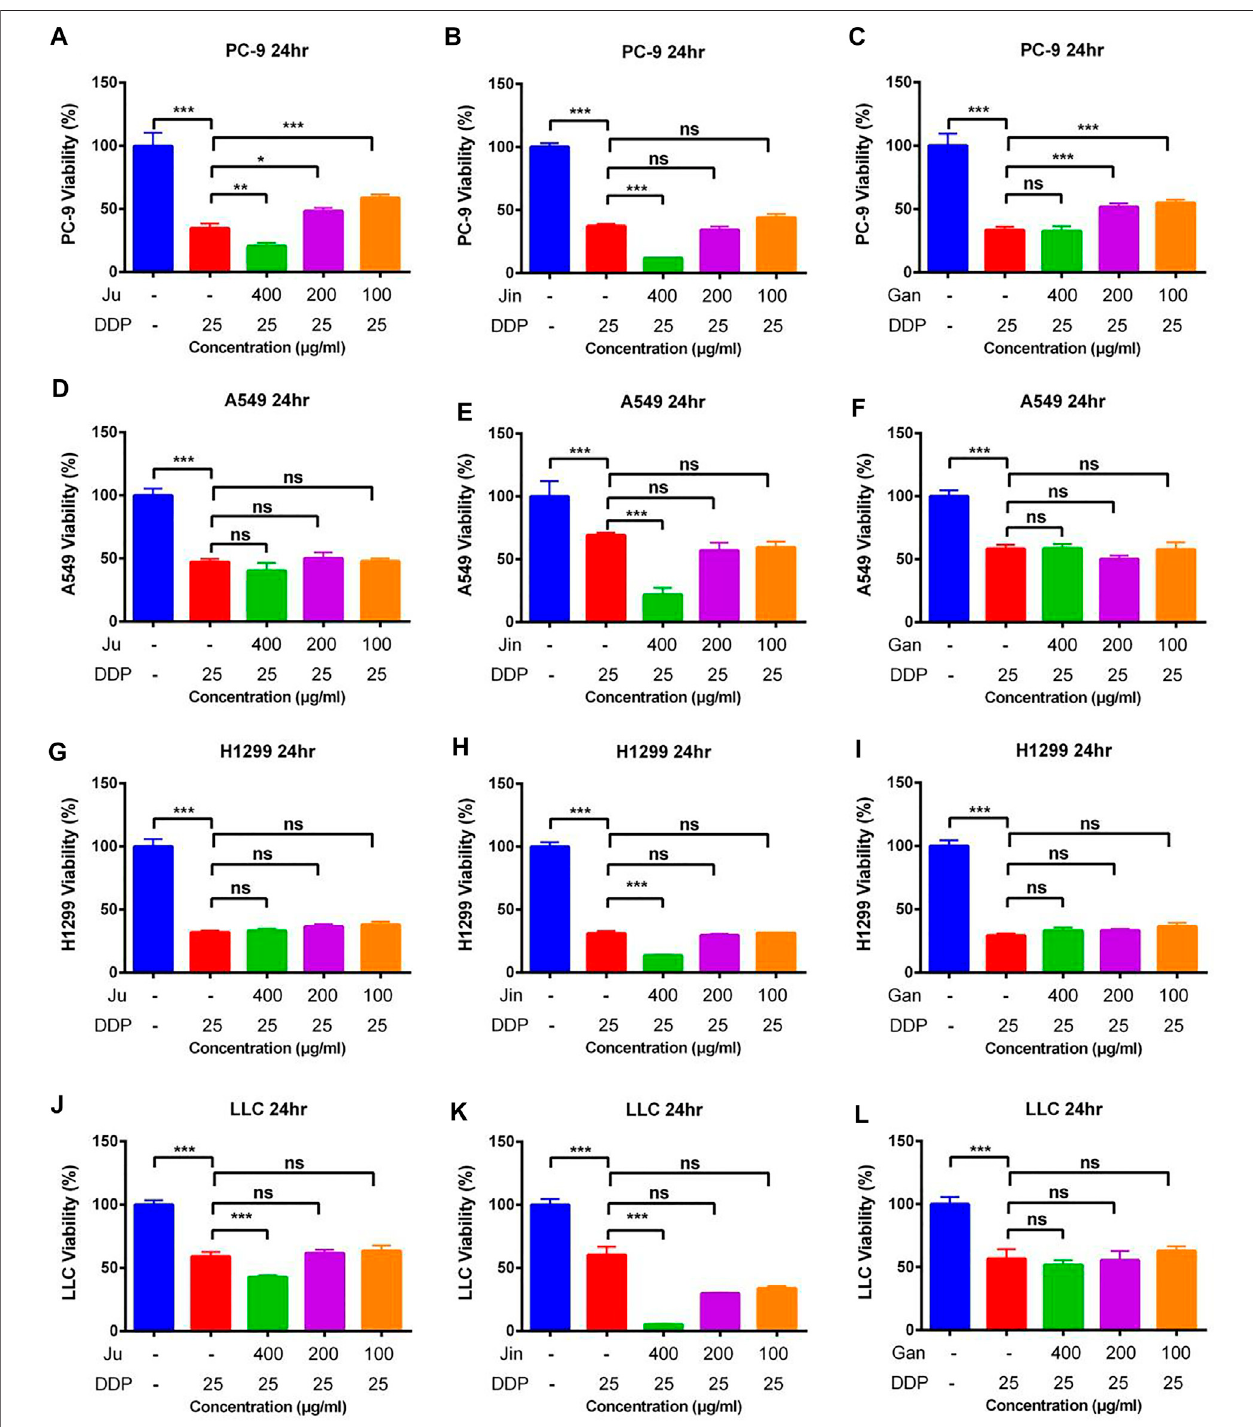
FIGURE 2 | The effect of single Chinese herbal medicine on the antitumor activity of DDP in vitro . (A – C) Dose of Ju, Jin, or Gan on the antitumor activity of DDP in PC-9cells. (D – F) DoseofJu,Jin,orGanontheantitumoractivityofDDPinA549cells. (G – I) DoseofJu,Jin,orGanontheantitumoractivityofDDPinH1299cells. (J – L) Dose of Ju, Jin, or Gan on the antitumor activity of DDP in LLC cells. Error bars are represented as mean ± SEM. p values were determined by Student ’ s t test (* p < .05, ** p < .01, *** p < .001).